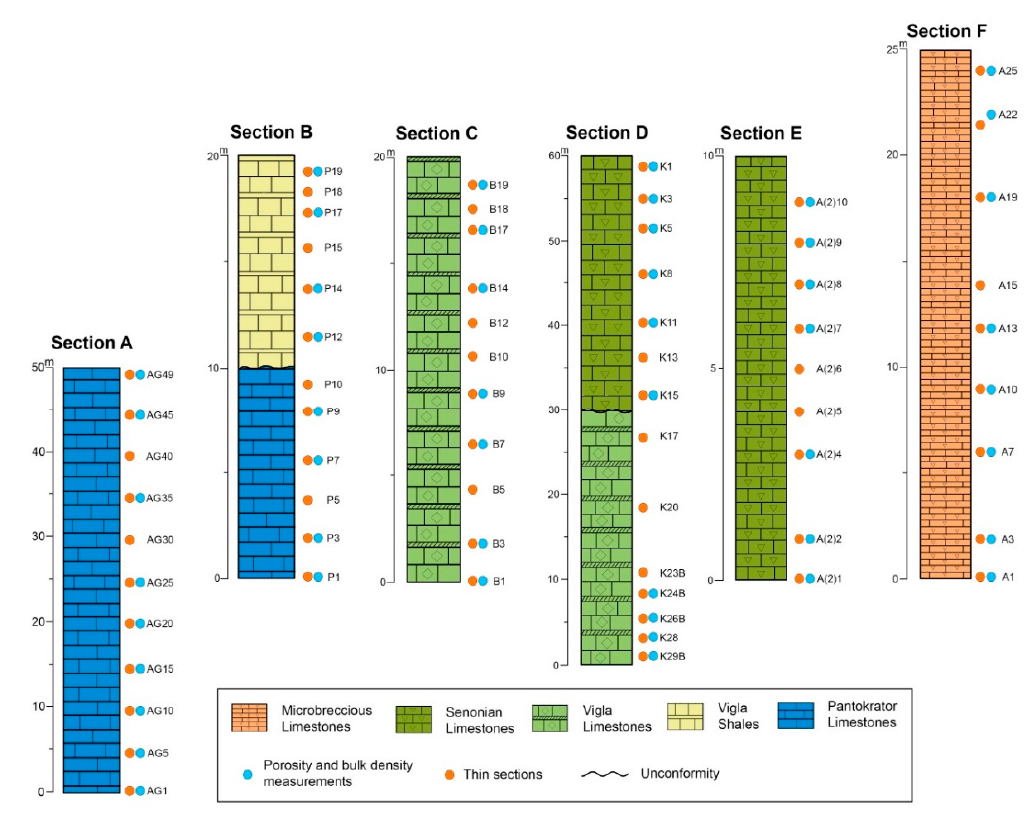
Figure 4. Lithology of the 6 study sections in Epirus region. The orange and blue circles at the right of each column represent the sampling intervals for thin sections as well as porosity and bulk density measurements.